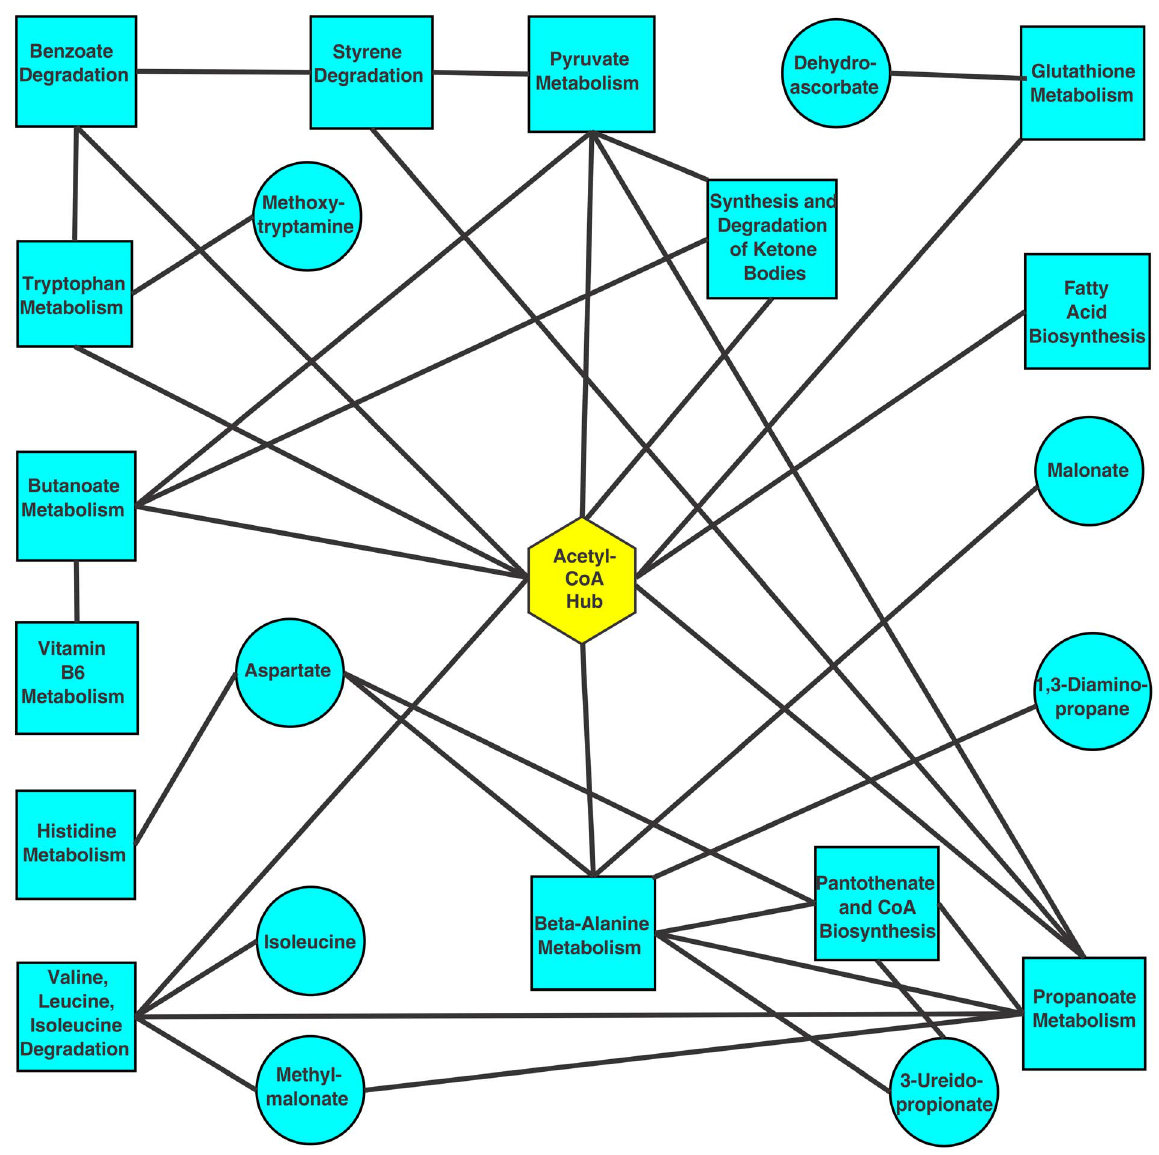
Figure 5. Acetyl-CoA appears to be a central hub connecting diverse pathways upregulated in Summer crowns and rhizomes. Cyan squares are KEGG pathways found to be upregulated in Summer plants by GSEA, and cyan circles are, and metabolites that were elevated in Summer plants relative to Kanlow plants. Edges connecting pathways (squares) to metabolites (circle) indicate that the given metabolite is found in the connected pathway. Pathways with direct connections in KEGG are also connected by edges. Acetyl-CoA (diamond) could be a potential linker molecule among these diverse pathways and is suggested to be a possible metabolic hub in Summer crowns and rhizomes entering dormancy.